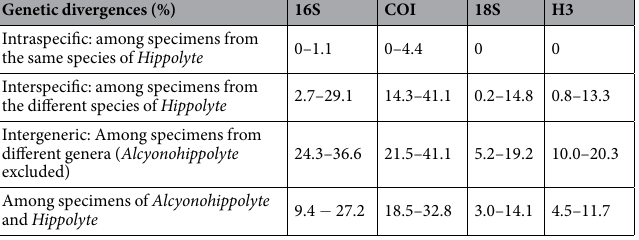
Table 1. Genetic divergences (%, Kimura 2-parameter) among the specimens analyzed. Data about the specimens can be obtained in the Supplementary Table